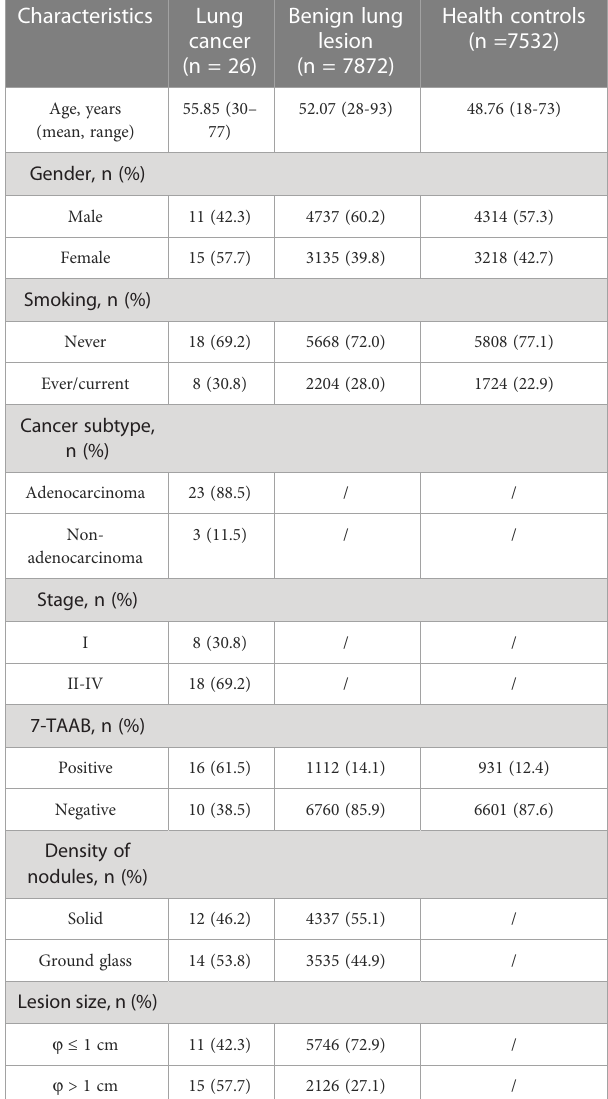
TABLE 2 Detection rates of pulmonary nodule by LDCT in the subjects of different genders and ages. Groups Subjects with pulmonary nodules,